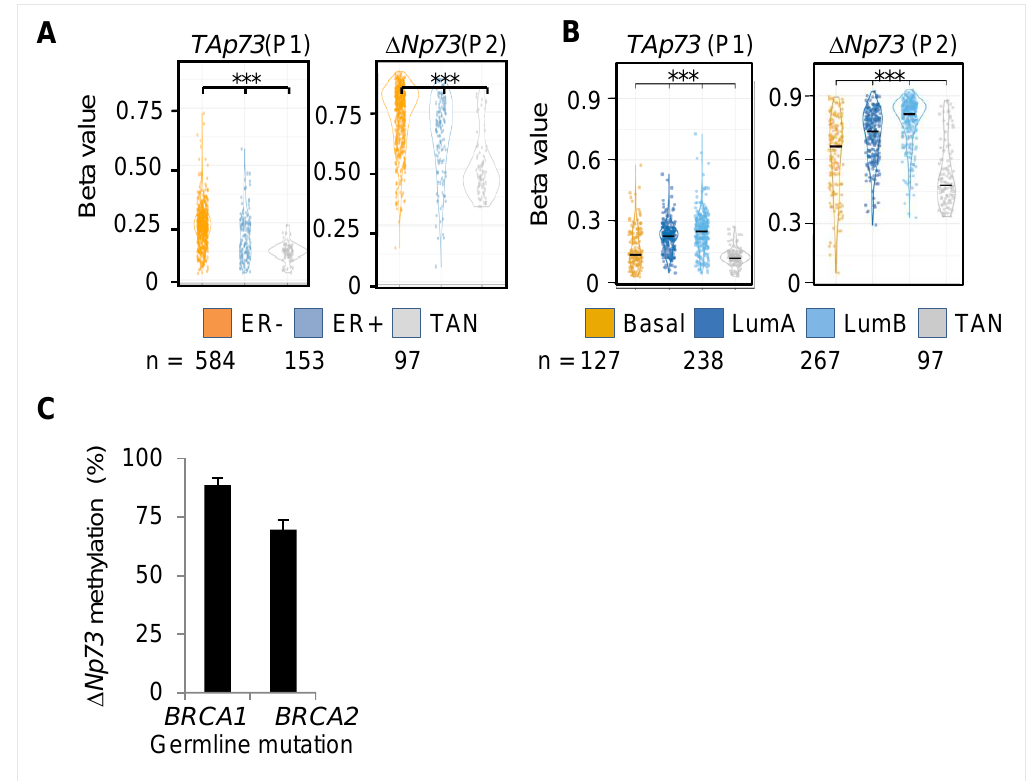
Figure 7. DNA methylation at the TP73 gene in breast cancers. ( A , B ) TCGA analysis shows distribution of average methylation groups for all Illumina probes located at the P1 or the P2 promoter regions among ( A ) ER+ and ER- breast tumors or ( B ) PAM50 breast tumor subtypes. *** represent p values < 0.001 by Welch two-sample t-test. ( C ) q-MSP analysis of the deltaNp73 promoter (P2) in breast tumors of BRCA1 ( n = 16) and BRCA2 ( n = 6) germline mutation carriers. Columns represent the mean ± S.E.M. ER - estrogen receptor, Lum – luminal, TAN – tumor adjacent normal tissue